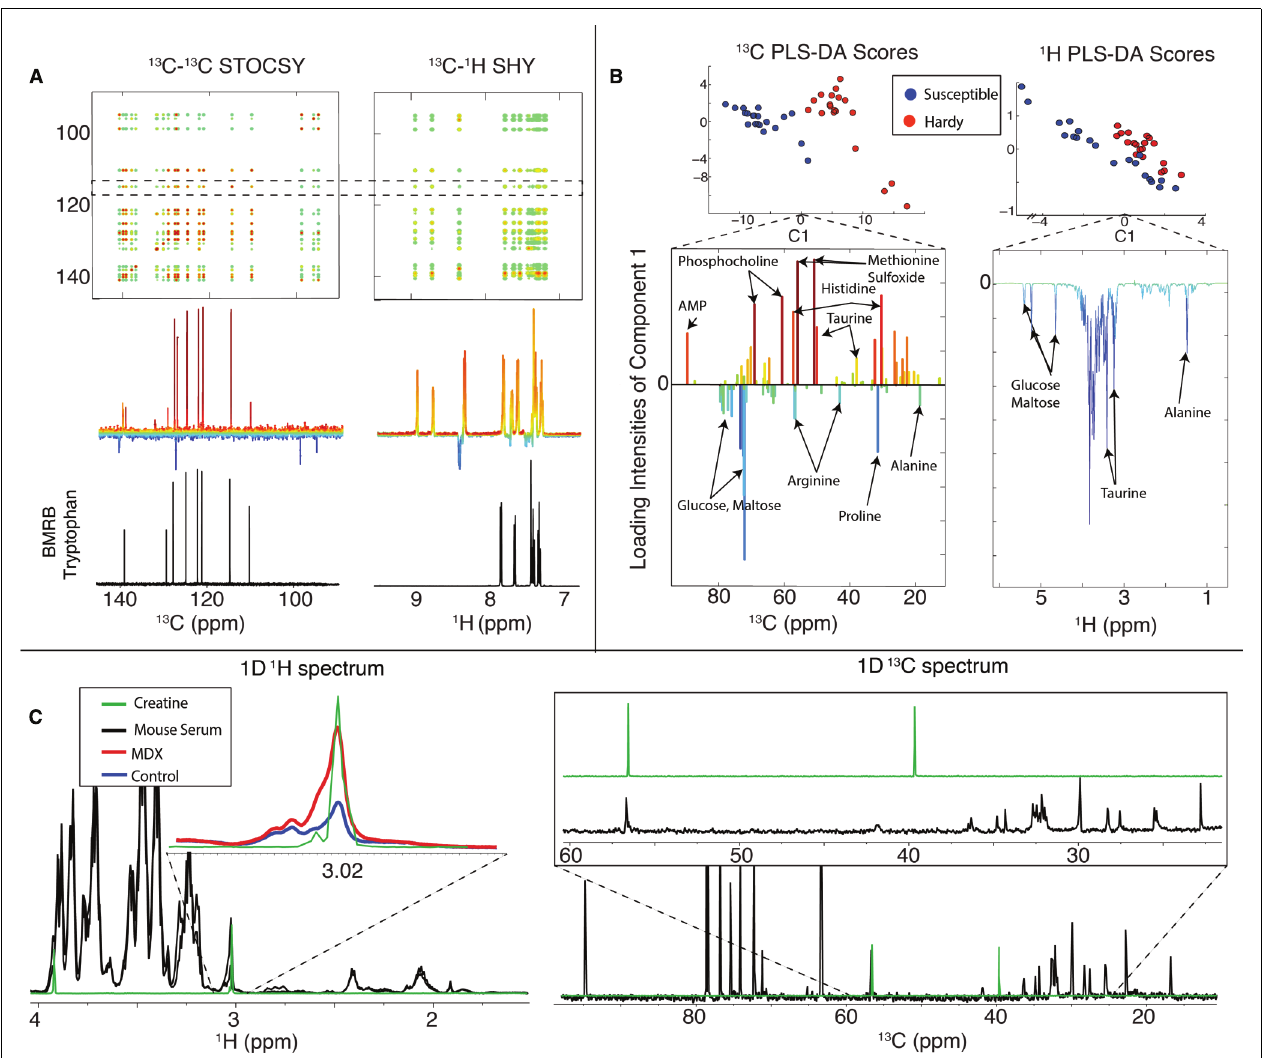
FIGURE 6 | Summary of natural abundance 13 C NMR metabolomics. In (A) we show 2D STOCSY and SHY correlation maps that were produced from the same mixture of 20 common metabolites that are shown in Figure 4 . We made two groups with five replicates each that had variation introduced by individual pipetting. The 2D 13 C– 13 C STOCSY spectrum in (A) is the 13 C statistical correlation map from all the 13 C 1D NMR data. The 2D 13 C– 1 H SHY is the statistical correlation map between 13 C and 1 H 1D NMR data. In (B) we present a summary of a PLS-DA of fruit flies that were either cold susceptible (blue) or cold hardy (red). The left side shows the PLS-DA using 13 C and the right side using 1 H data. The improved 13 C spectral